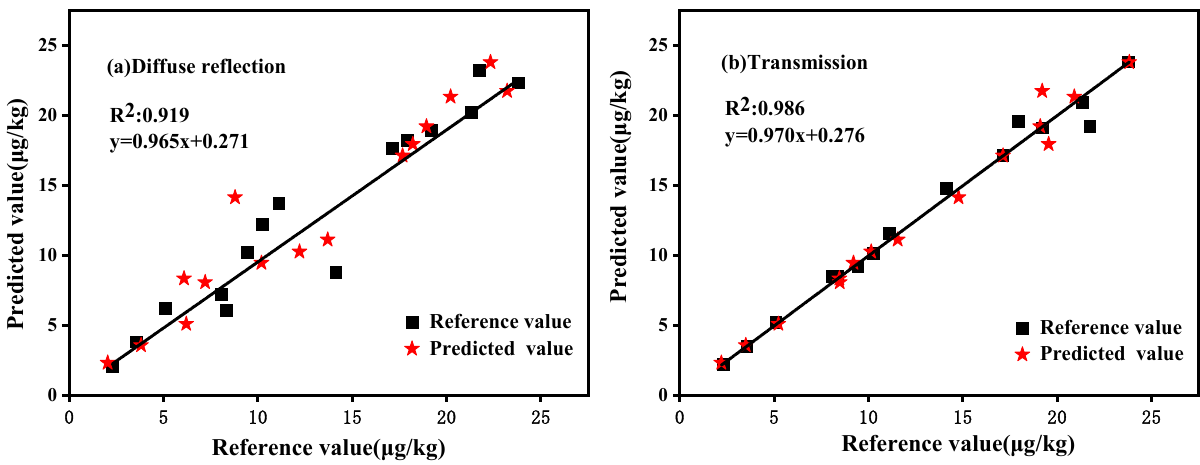
Figure 12. External validation of the reference and predicted concentrations of AFB 1 in peanuts.